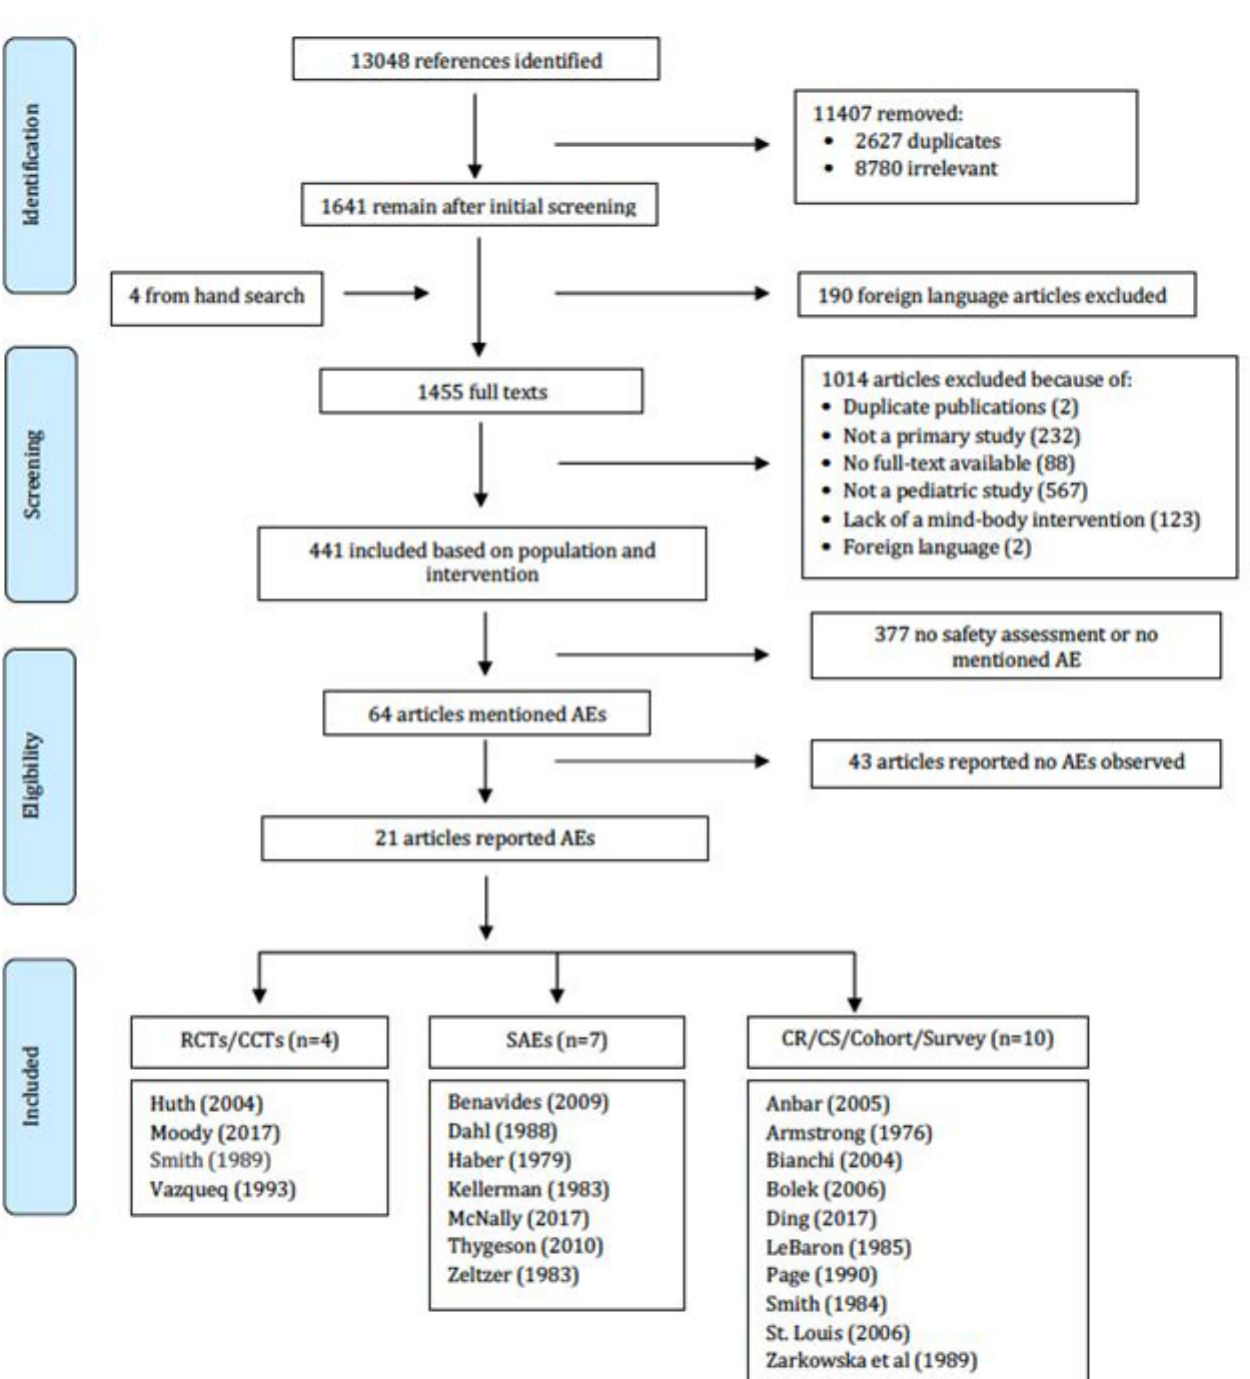
Figure 1. PRISMA diagram of study selection for pediatric mind-body adverse events. AE: adverse event; CCT: controlled clinical trial; CR: case report; CS: case series; RCT: randomized controlled trial; SAE: single-arm experimental